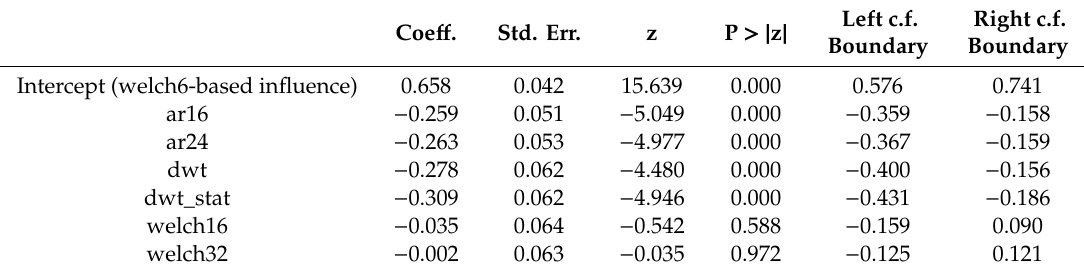
Table 16. Coe ffi cients of a linear model calculated by the analysis procedure, standard error, statistic, and p -value of a test for statistical significance and left and right boundaries of the confidence interval for the influence of each algorithm in comparison to the reference algorithm (welch64).